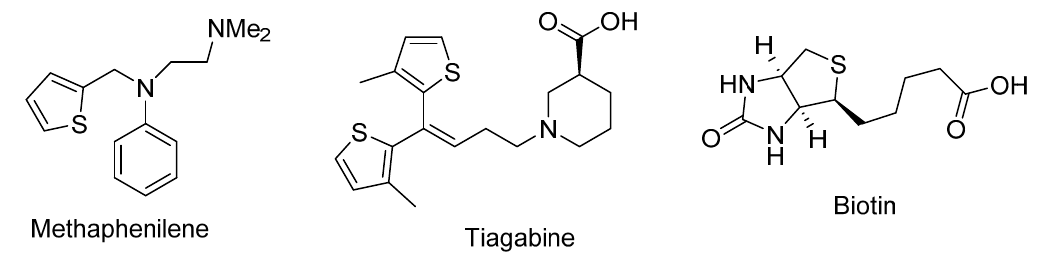
Figure 1. Example of important bioactive thiophenes.